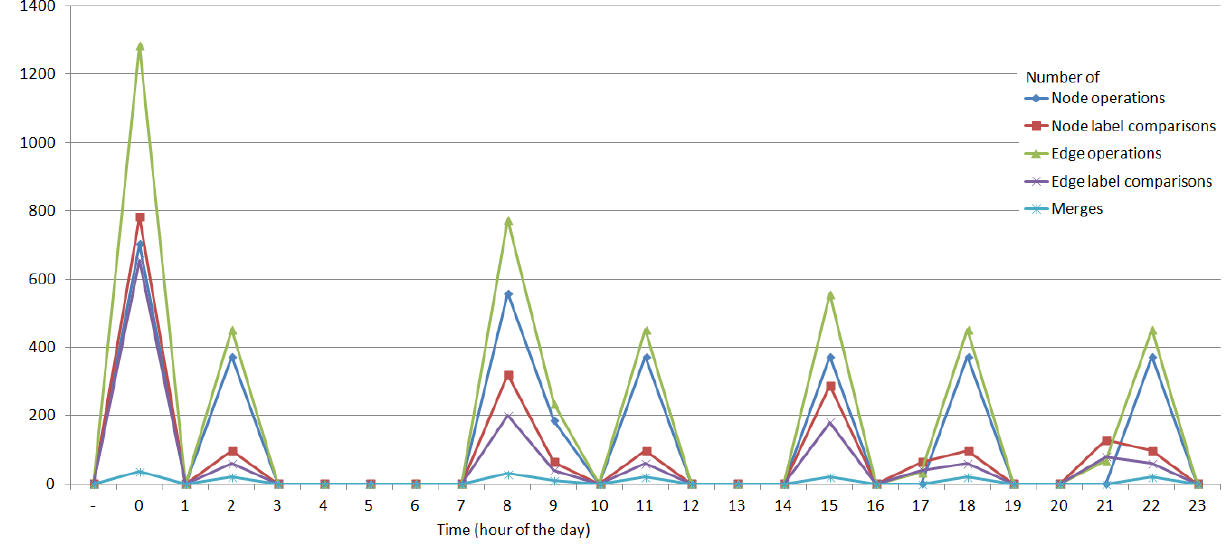
Figure 9. A plot of the number of compared node references and labels, edge references and labels and match merges, depending on the time in the simulated scenario in Section